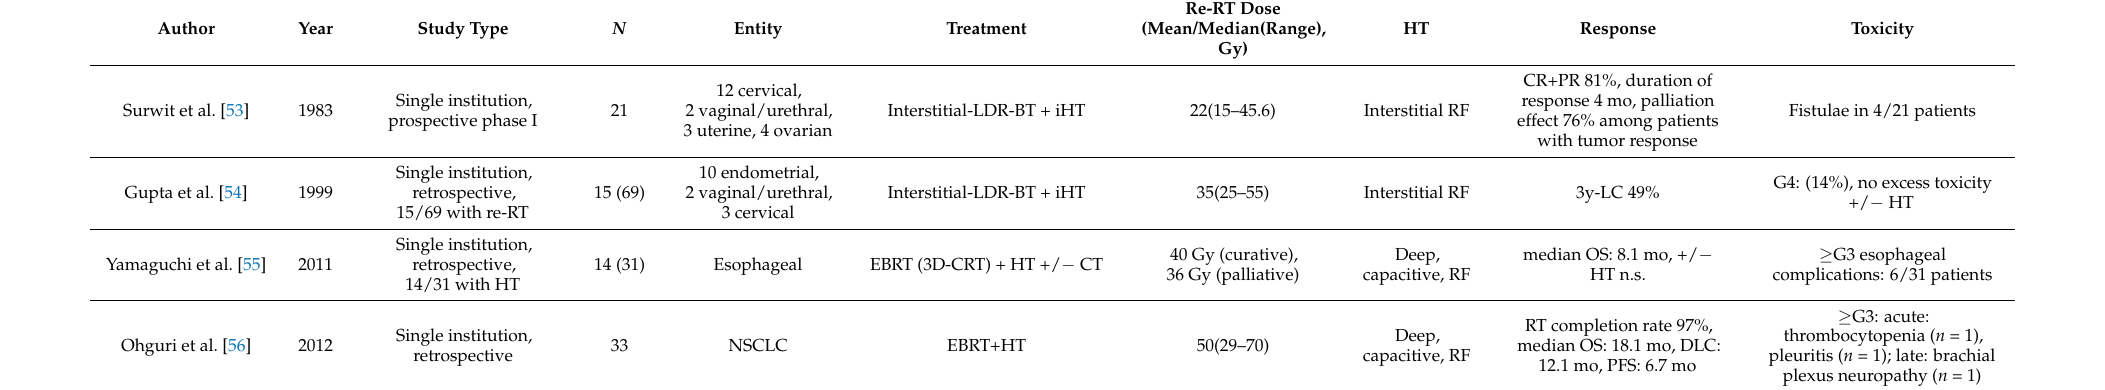
Table 6. Other cancer